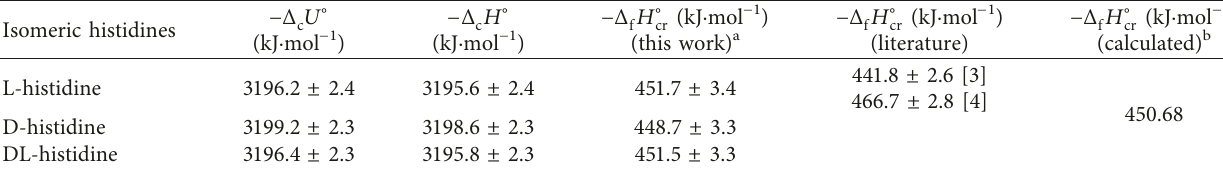
Table 2: Enthalpies of combustion and formation in solid state of isomeric histidines.